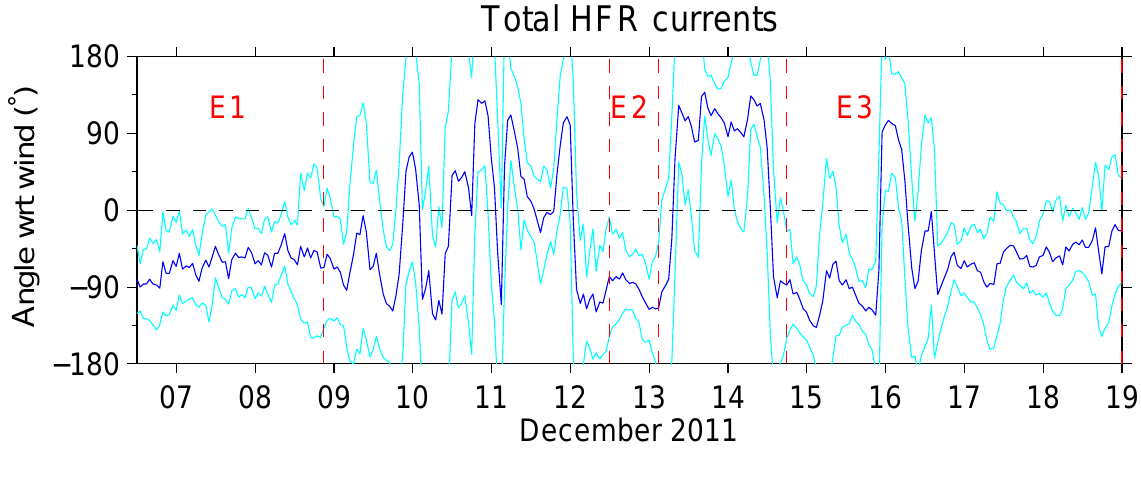
Figure 10. Spatially averaged angle ¯ α(t) between total surface currents u S and average ALADIN winds over the HFR coverage (blue line). The black dashed line indicates a 0 ◦ angle. Negative angles indicate currents to the right of the wind direction. The cyan lines represent the SD. The limits of the selected wind events (E1, E2, and E3) are indicated with red dashed lines (see Fig. 2b for more